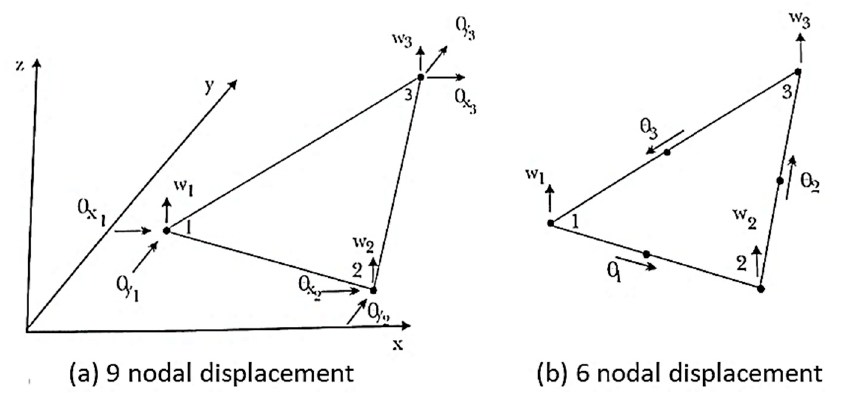
Figure 18. Non-conforming triangular elements. Reproduced with permission [75] .